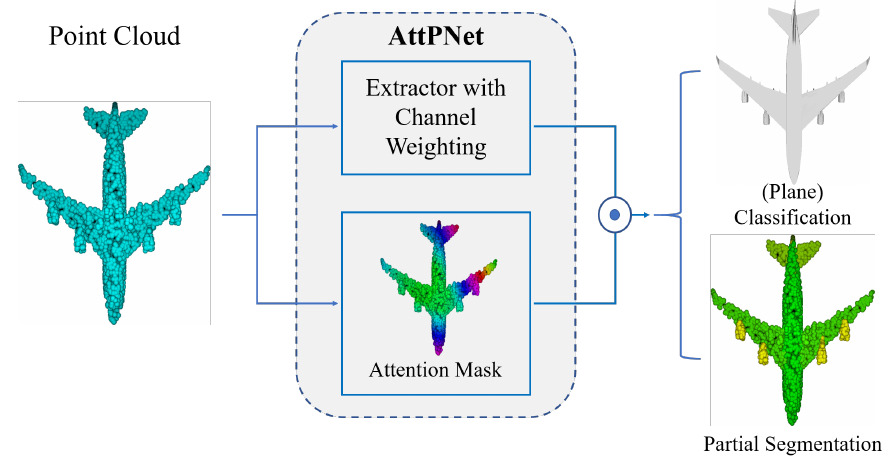
Figure 1. Overview of